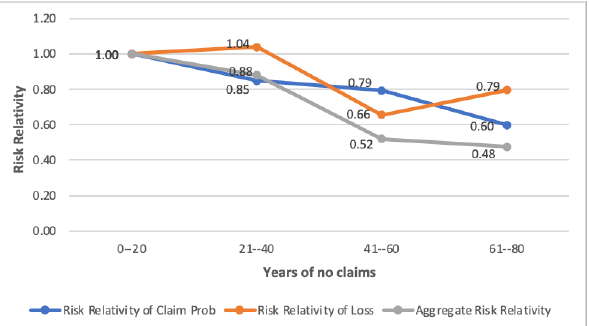
Figure 18. Risk relativities by grouped Years of no Claims based on loss severity, frequency, and loss cost (aggregate risk),